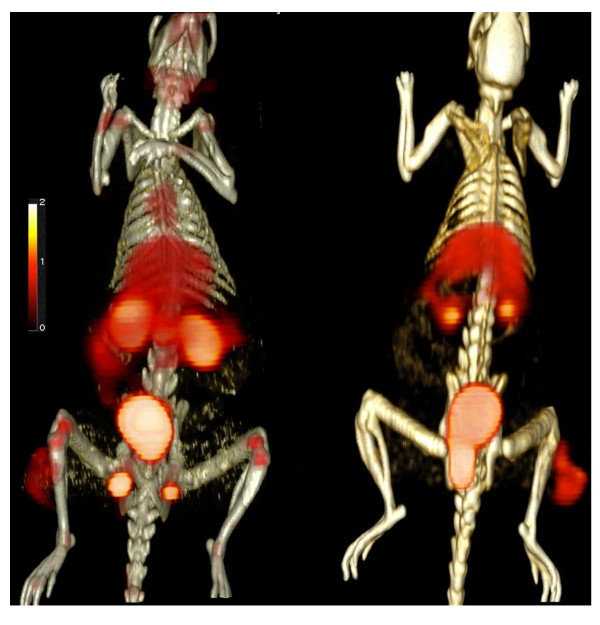
3D fused PET-CT images for 68Ga-RGD4 (left) and 68Ga-Bombesin (right). Besides the tumor region in the lower leg. The tracer uptake in other sites covered heart (exhibit for 68Ga-RGD4), liver, kidney, urinary bladder, and testicles (left for male rat).